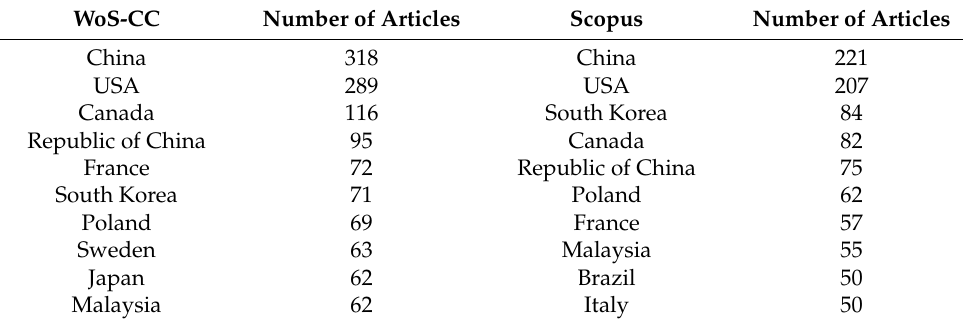
Table 1. Number of articles in years indexed in WoS-CC and Scopus in countries.